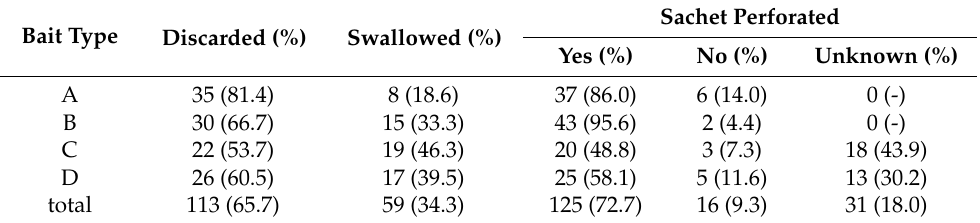
Table 7. Fate of the sachet in relation to bait type. Sachet discarded versus swallowed and sachet perforated versus not